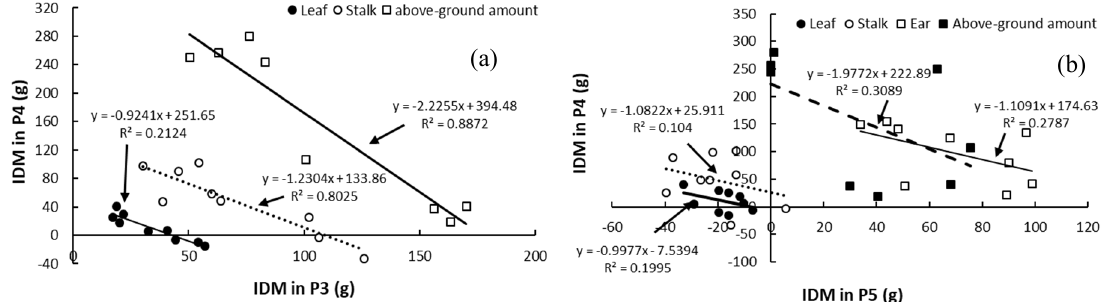
Figure 8. Correlation between stage P4 and stage P3 ( a ), and that between stage P4 and stage P5 ( b ) in terms of the IDMs of different organs of maize.